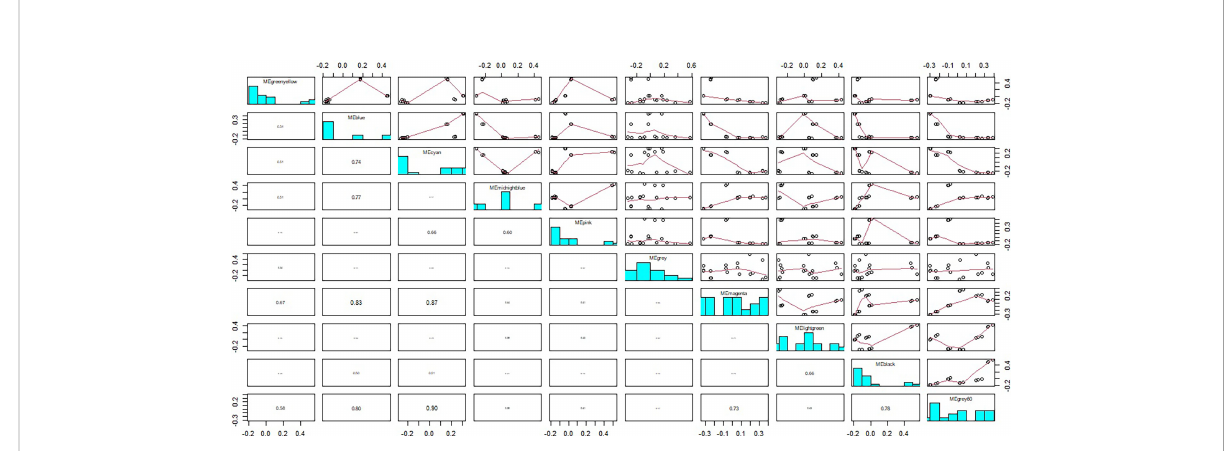
FIGURE 5 The relationship between module eigengenes. The numbers in column indicated correlation ratios between different